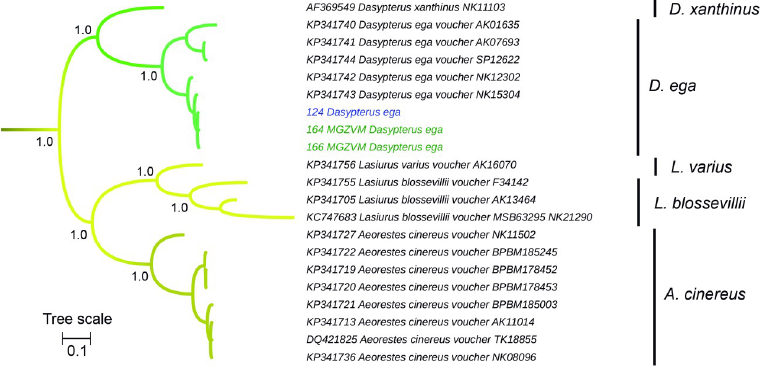
Fig 4. Cytochrome b -based Bayesian phylogeny of Dasypterus , Lasiurus , and Aeorestes . Branch width represents internal node support. Terminal font color indicates sequence source: black indicates sequences retrieved from Genbank, green indicates museum voucher sequences obtained in this study, while blue color indicates samples captured at the field and sequenced in this study. The scale units are substitutions per site. Main clades posterior probability values are